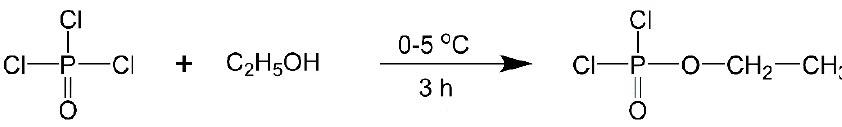
Scheme 1. The synthesis process of ethyldichlorophosphate.